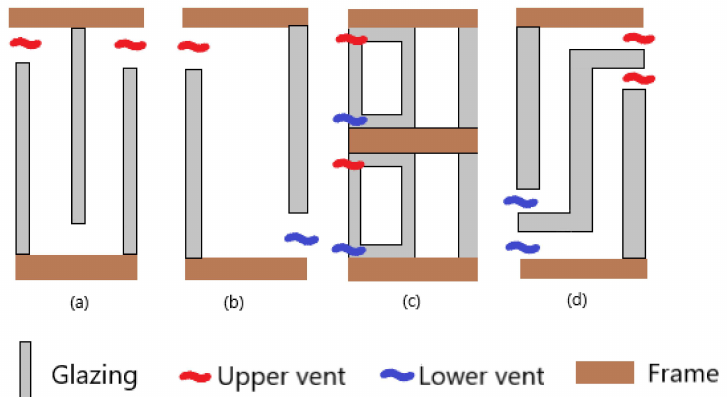
Figure 1. Schematic diagram of the various ventilated windows: ( a ) Paziaud window; ( b ) ventilated double-glazing window; ( c ) double-skin window; ( d ) double airflow